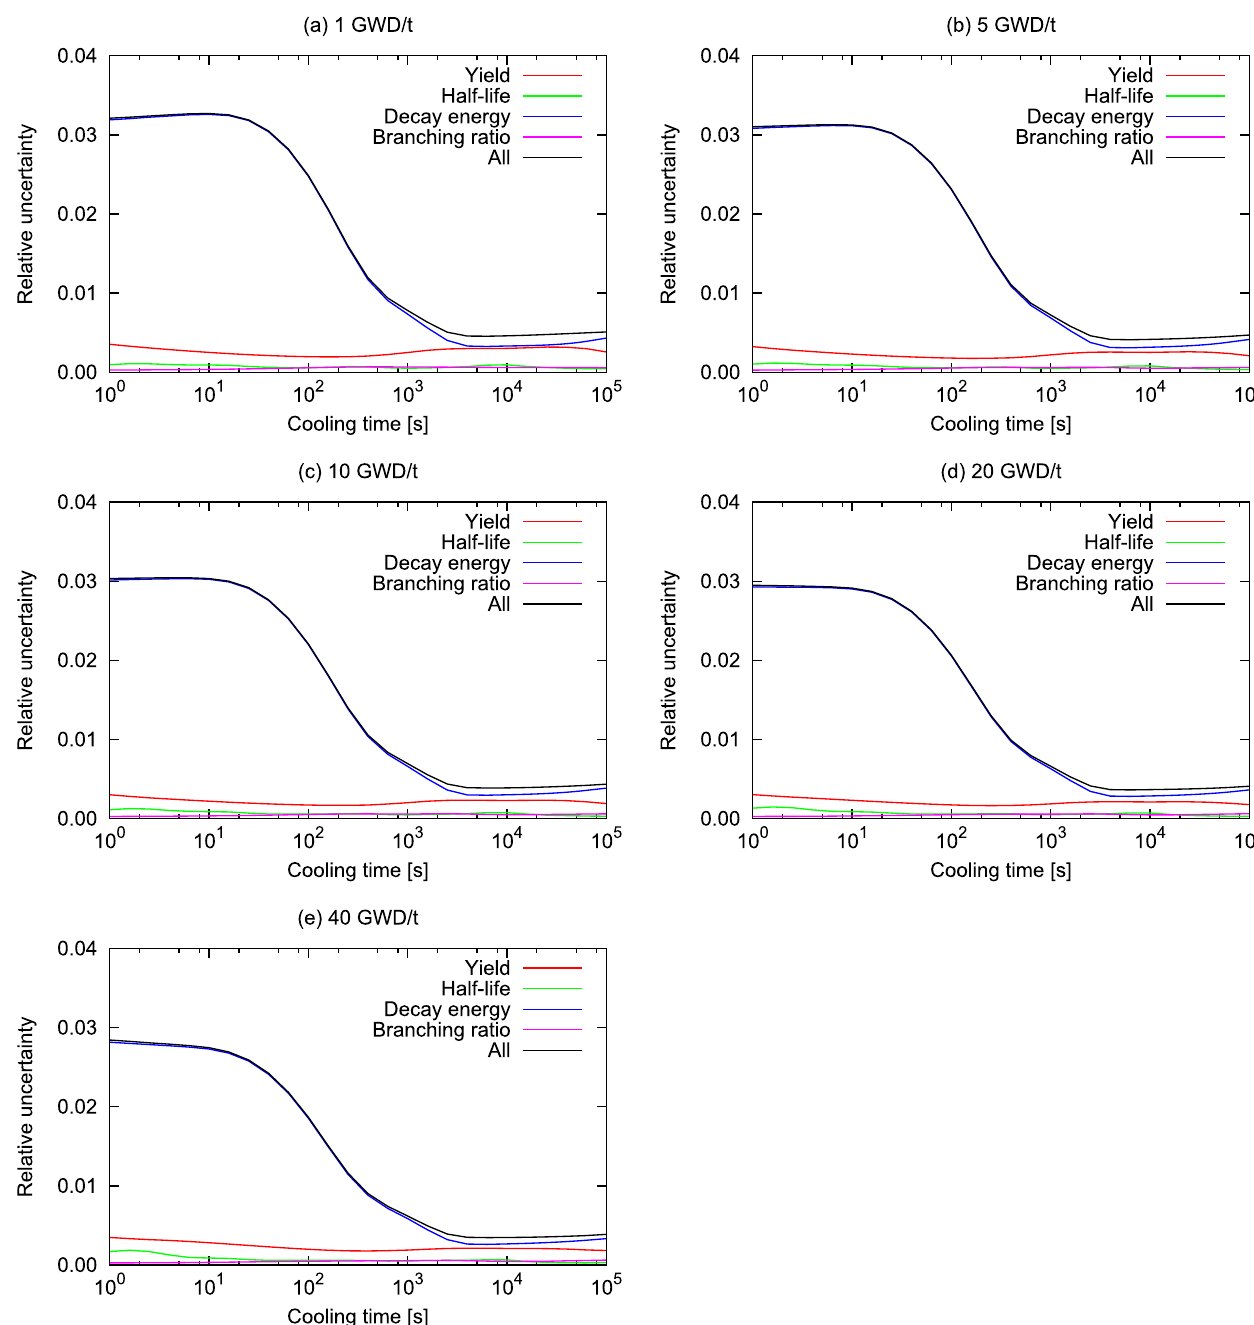
Fig. 8. Nuclear data-induced uncertainty of decay heat after uranium-235 fi ssion with thermal neutrons with different burnup. Default uncertainty is assumed